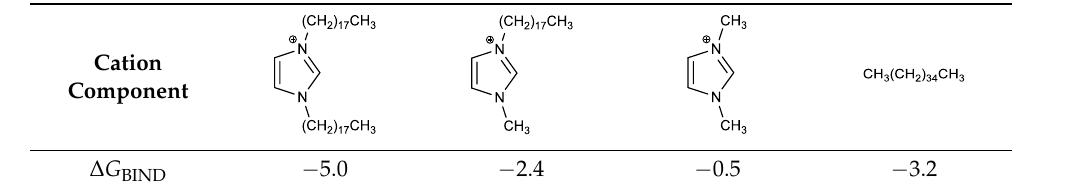
Table 1. MM-PBSA calculated binding affinities ( ∆ G BIND , in kcal mol − 1 ) among the TPB − anion and Table 1. MM- PBSA calculated binding affinities (Δ G BIND , in kcal mol – 1 ) among the TPB – anion and Table 1. MM- PBSA calculated binding affinities (Δ G BIND , in kcal mol – 1 ) among the TPB – anion and Table 1. MM- PBSA calculated binding affinities (Δ G BIND , in kcal mol – 1 ) among the TPB – anion and Table 1. MM- PBSA calculated binding affinities (Δ G BIND , in kcal mol – 1 ) among the TPB – anion and Table 1. MM- PBSA calculated binding affinities (Δ G BIND , in kcal mol – 1 ) among the TPB – anion and selected cations following the molecular dynamics simulation in water. selected cations following the molecular dynamics simulation in water. selected cations following the molecular dynamics simulation in water. selected cations following the molecular dynamics simulation in water. selected cations following the molecular dynamics simulation in water. selected cations following the molecular dynamics simulation in water.